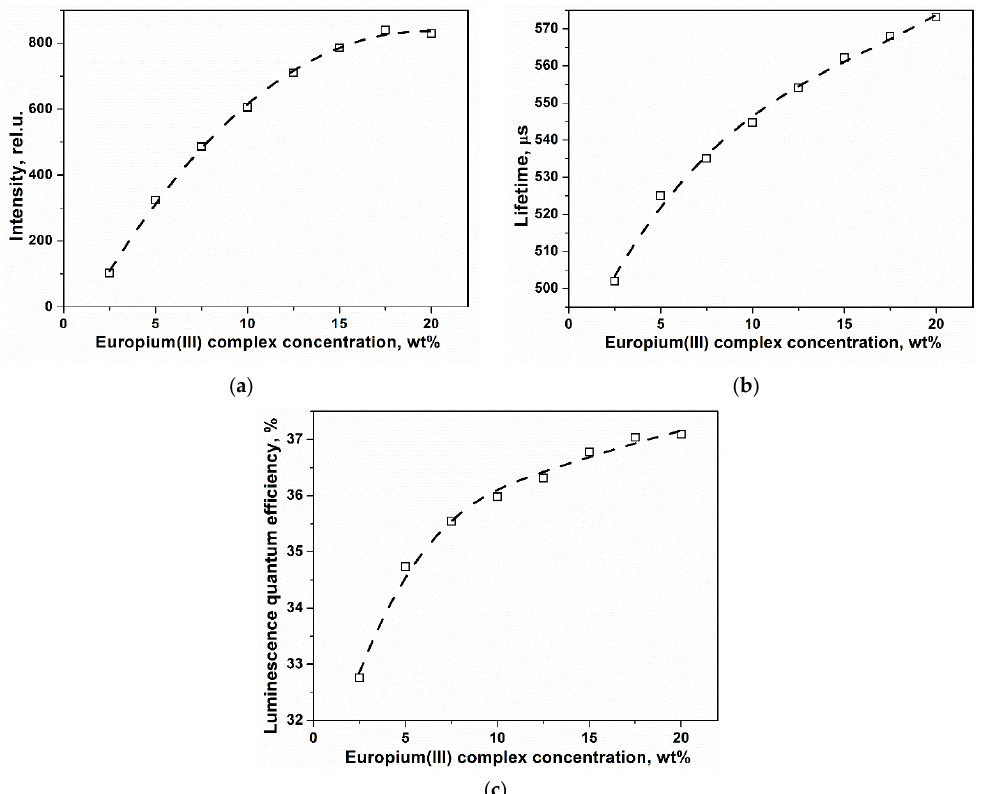
Figure 3. Concentration dependence of luminescence intensity ( a ), lifetime ( b ) and quantum efficiency Φ Ln ( c ) of PLA composite films doped with the Eu(III) complex at λ ex = 340 nm and λ em = 613 nm (marker symbols—experimental data, dashed line—approximation).